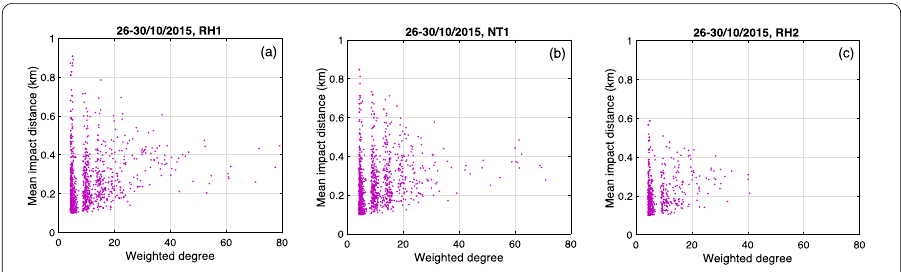
Figure 12 Mean impact distance VS weighted degree. ( a ) During RH1 ( b ) During NT1. ( c ) During RH2. The data is during 26–30 Oct. 2015, N = 4530, L = 900, and τ max = 150. Pearson’s correlation: ( a ) 0.2402, ( b ) 0.2226, ( c )